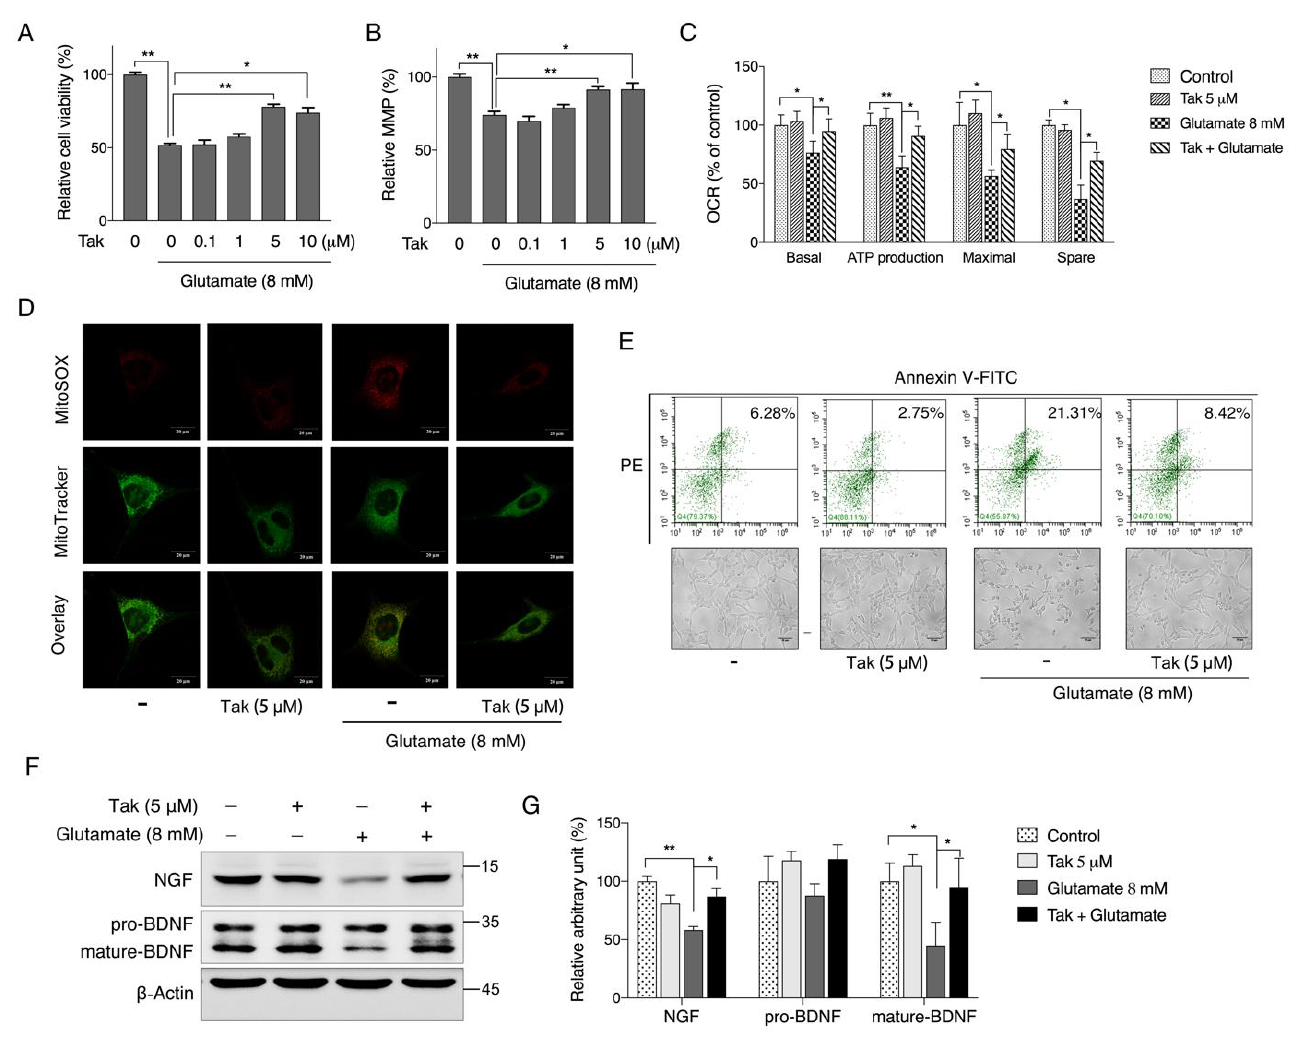
Figure 4. Tak inhibits glutamate-induced cell apoptosis. HT22 cells were treated with Tak at concentrations of 0, 0.1, 1, 5, and 10 µ M for 24 h, followed by glutamate treatment (8 mM) for 12 h, and cell viability ( A ), MMP ( B ), and oxygen consumption rate ( C ) was analyzed. HT22 cells were treated with Tak at a concentration of 5 µ M for 24 h, followed by glutamate treatment (8 mM) for 12 h, and the mitochondrial superoxide level was assessed by fluorescent confocal microscopy ( D ), cell apoptosis was analyzed by flow cytometry ( E ), and protein expressions of NGF and BDNF were analyzed by western blot (( F ): western blot images; ( G ): statistical analysis). The values are presented as the mean ± S.E.M. from at least three independent experiments. * p < 0.05 and ** p < 0.01 between the connected groups.